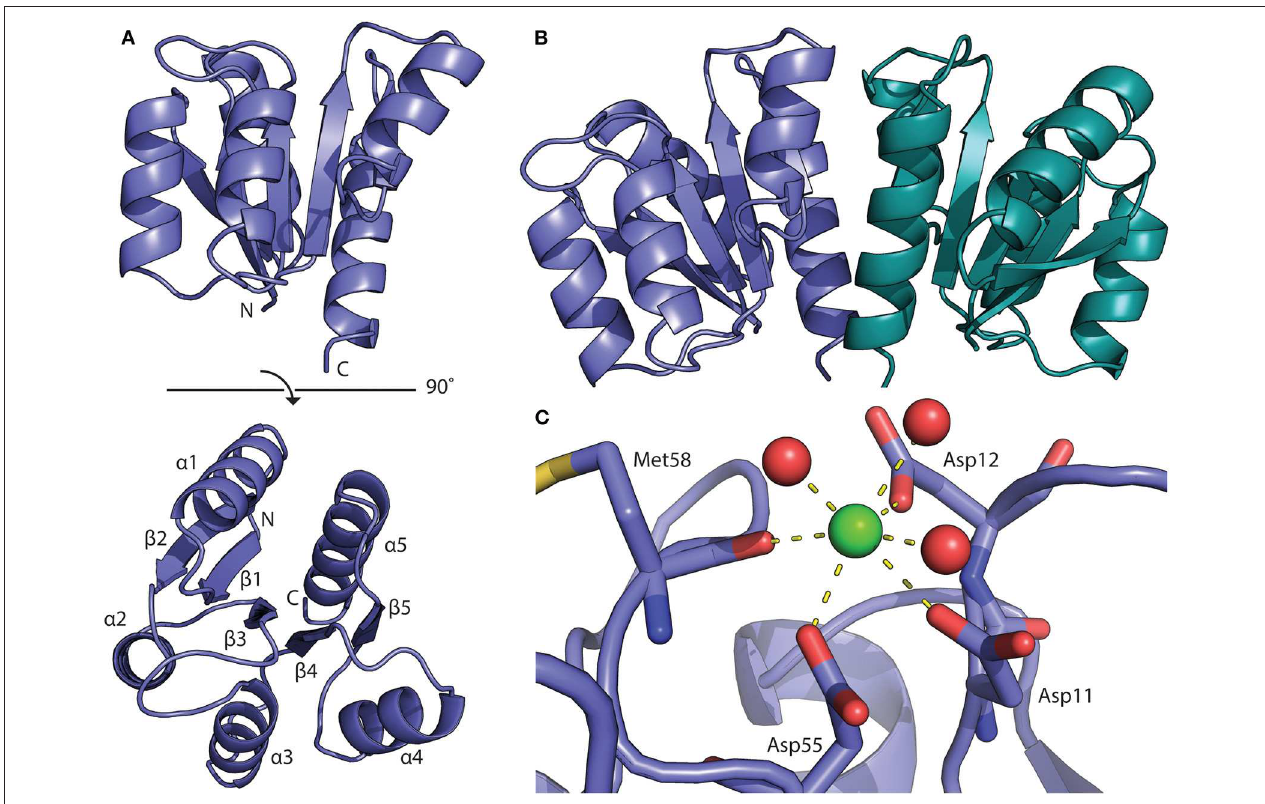
FIGURE 2 | Structure of the BfpR receiver domain. (A) Crystal structure of the N-terminal BfpR receiver domain solved to 1.8 Å. (B) Structure of BfpR receiver domain dimer with one monomer in blue and one in green. An adjacent symmetry mate forms the biologically relevant dimer. (C) Phosphorylation occurs at the conserved aspartate residue (Asp55). A calcium ion (green spheres) is located in the active site and is coordinated with active site residues and water molecules (red spheres) as seen in crystal structure of other phosphorylated response